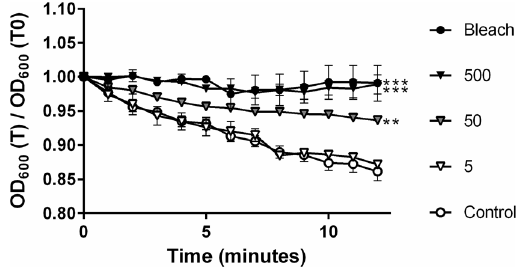
Figure 1. C . difficile spore germination was significantly inhibited in spores treated with Fe 3- δ O 4 nanoparticles. Purified CCUG 37780 spores were incubated in BHIS medium containing Fe 3- δ O 4 nanoparticles ([500 µ g/mL ( ▲ ), 50 µ g/mL ( ), or 5 μ g/mL ( ▵ )]), or 3% sodium hypochlorite as a positive control. The kinetics of spore germination was analyzed using spectrometric absorption referenced to the starting point. OD 600 (T) = different time points after taurocholate treatment; OD 600 (T 0 ) = time zero. Spore germination was significantly inhibited in spores treated with Fe 3- δ O 4 nanoparticles. ( *** P < 0.001; one-way analysis of variance [ANOVA] followed